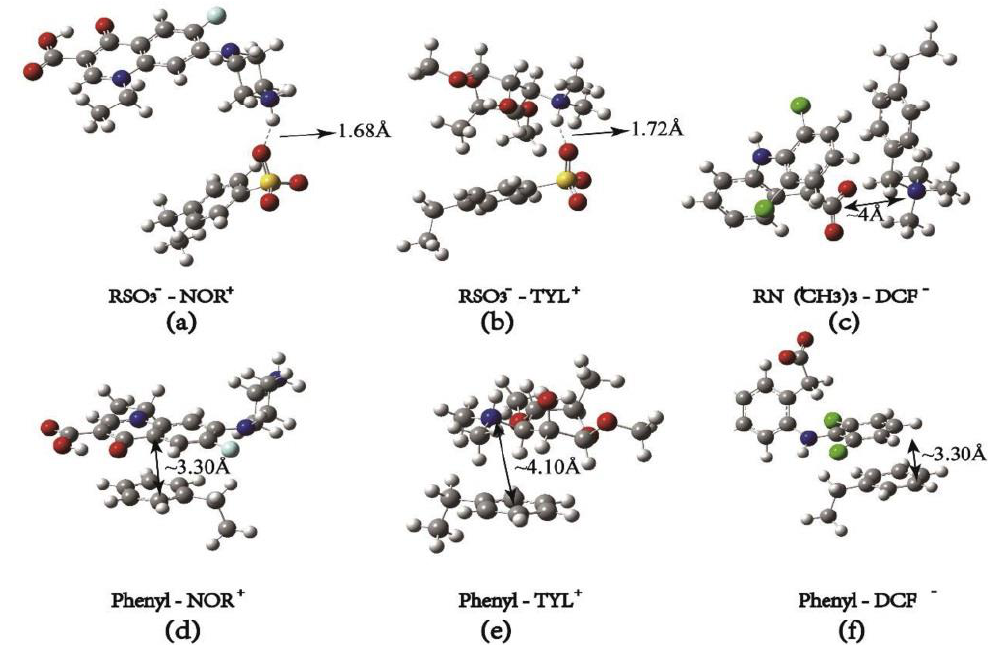
Figure 15. Optimized conformation of ( a )RSO 3 − -NOR + , ( b ) RSO 3 − -TYL + , ( c ) RSO 3 − -DCF − , ( d ) phenyl-NOR + , ( e ) phenyl-TYL + , and ( f ) phenyl-DCF − derived from DFT calculations [21].